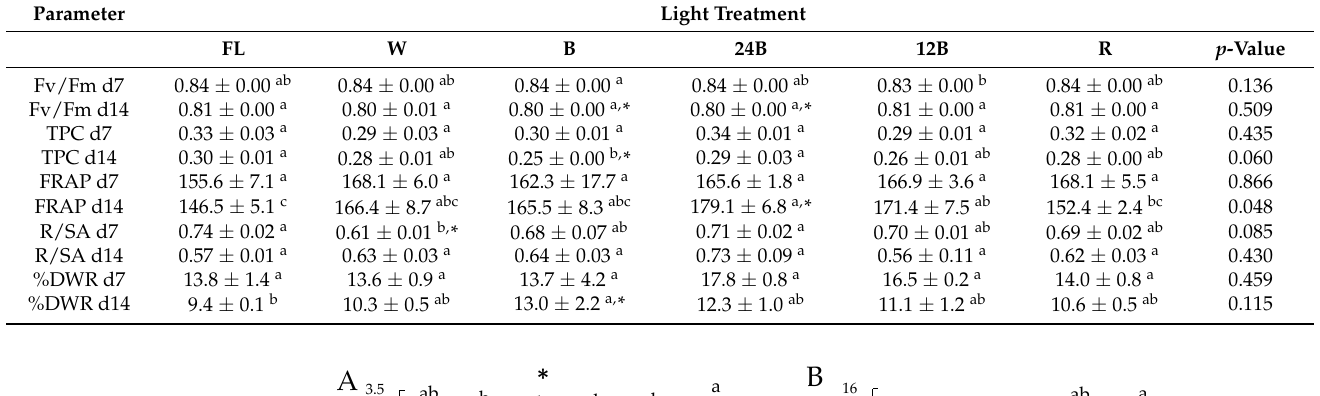
in μ g/g; ferric reducing antioxidant power; R/SA in g/cm 2 : root dry weight/surface area; %DWR: percentage of root dry weight; FL: fluorescent lamps; W: white; B: blue; 24B: 24% blue; 12B: 12% blue; R: red. Mean values followed by different letters are significantly different at p ≤ 0.05 ac- cording to the LSD method. Asterisks indicate significant differences between the LED treatments and the control (FL) at p ≤ 0.05 according to t -test.